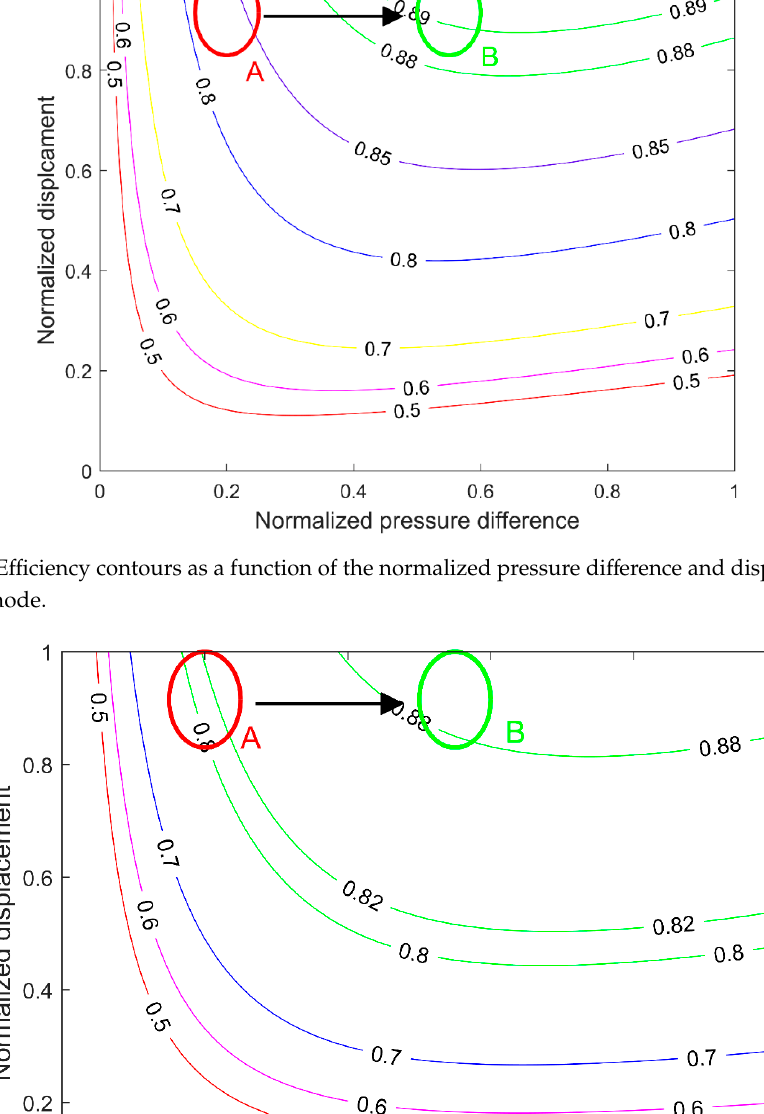
Figure 11. Efficiency contours as a function of the normalized pressure difference and displacement in pumping mode.